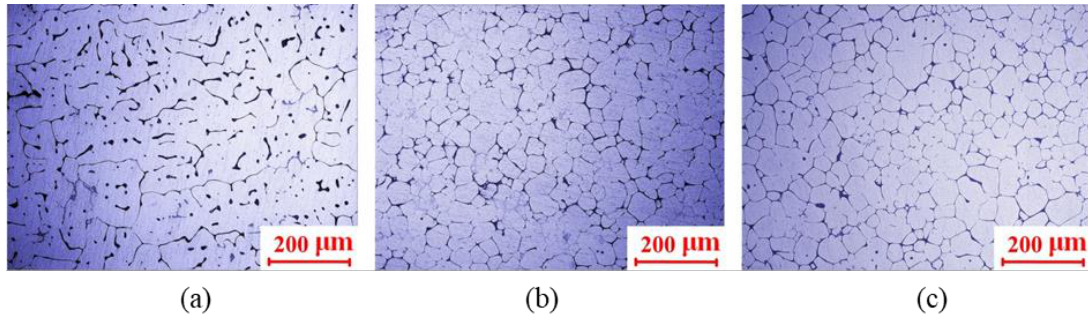
Figure 21. The microstructure of 2A50 alloy ( a ) prepared without EMS, ( b ) the central, and ( c ) edge samples of semi-solid 2A50 alloy prepared by EMS with the medium-level EMS.